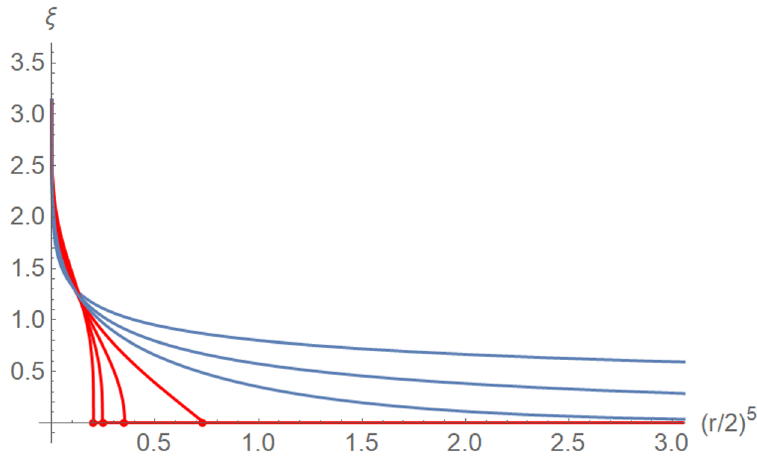
Figure 2 . Numerical solutions for equation (3.19) with pion-mass type potential to the power s = 1 , 2 , . . . , 8 for d = 5 spatial manifold. The red curves represent s = 1 , 2 , 3 , 4 cases, and the blue curves represent s = 5 , 6 , 7 cases. We can see that for higher s the profile of ξ decays slower as r → ∞ .